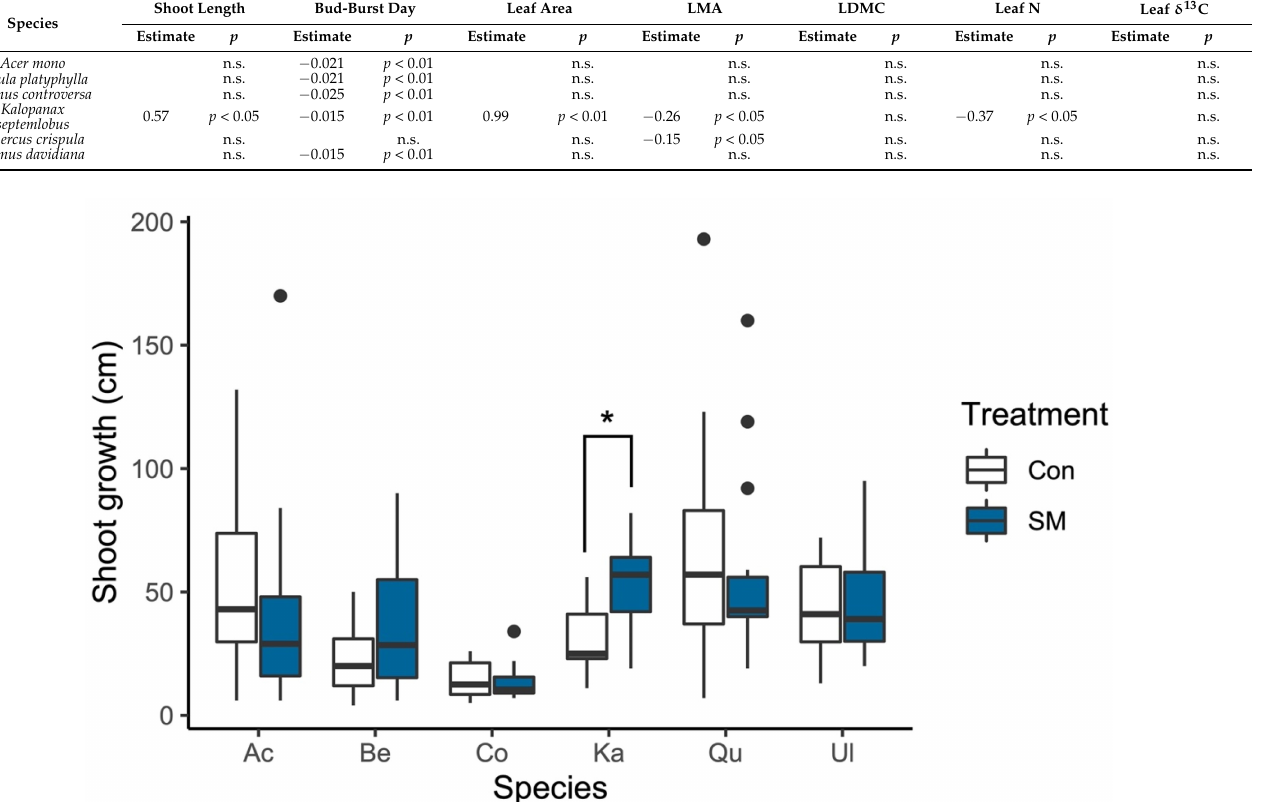
Figure 4. The shoot growth of six tree species in June 2017 as influenced by the snowmelt treatment. The white boxes represent the data of the control (Con) and the blue boxes represent the snowmelt (SM) treatment. (n > 9). Ac = Acer mono , Be = Betula platyphylla , Co = Cornus controversa , Ka = Kalopanax septemlobus , Qu = Quercus crispula , and Ul = Ulmus davidiana. *: p < 0.05 by GLMM (for K. septemlobus , GLM